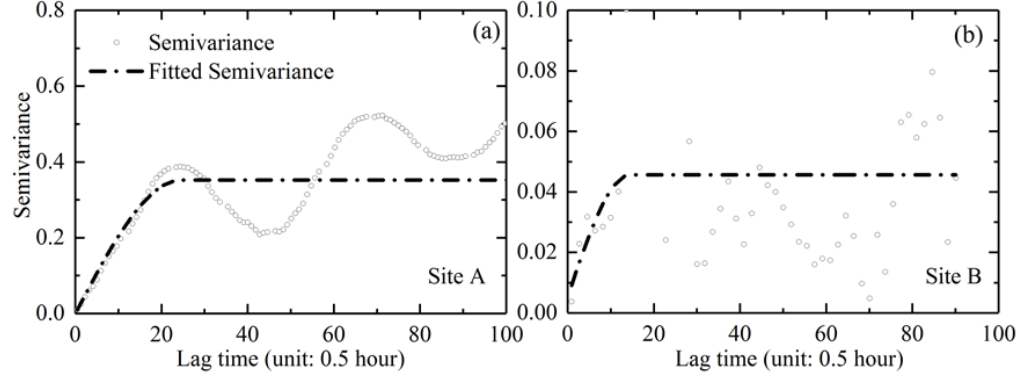
Figure 11. Temporal scales of Chl-a levels based on high-frequency measurements. The fitted spherical models are represented by the solid black lines.